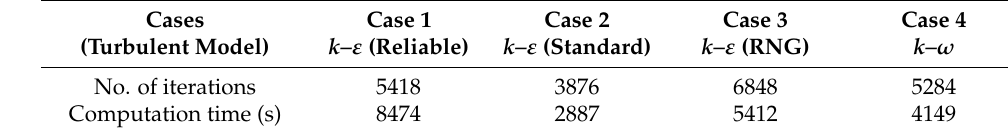
Table 3. Simulation cases with different turbulent models.